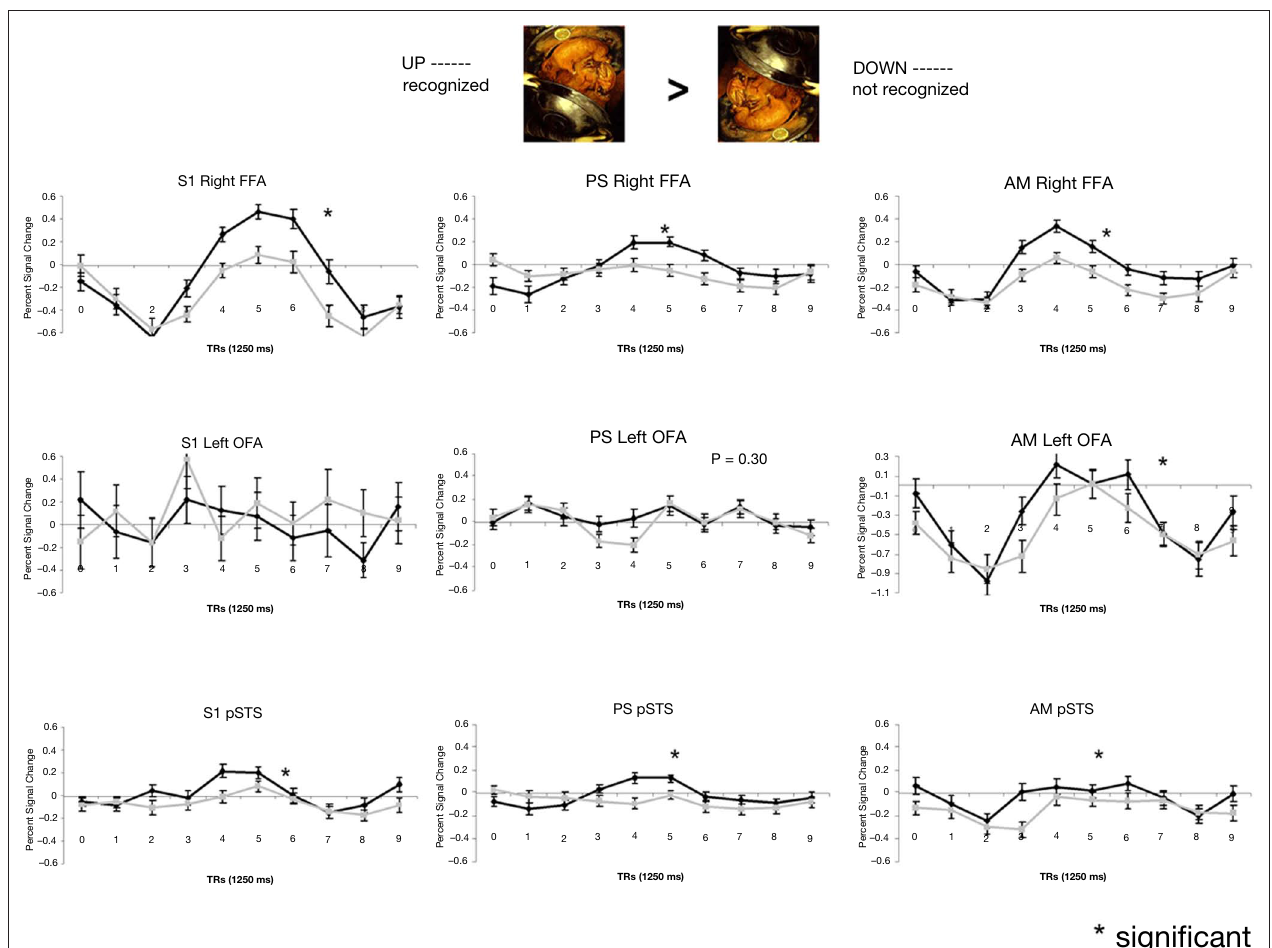
to the same pictures presented upside-down (“non-faces”). Similar findings are made for the control group (e.g., A1 illustrated here), although there was a small effect for AM’s left OFA (but with a t-value corresponding to 50% of the t of her own